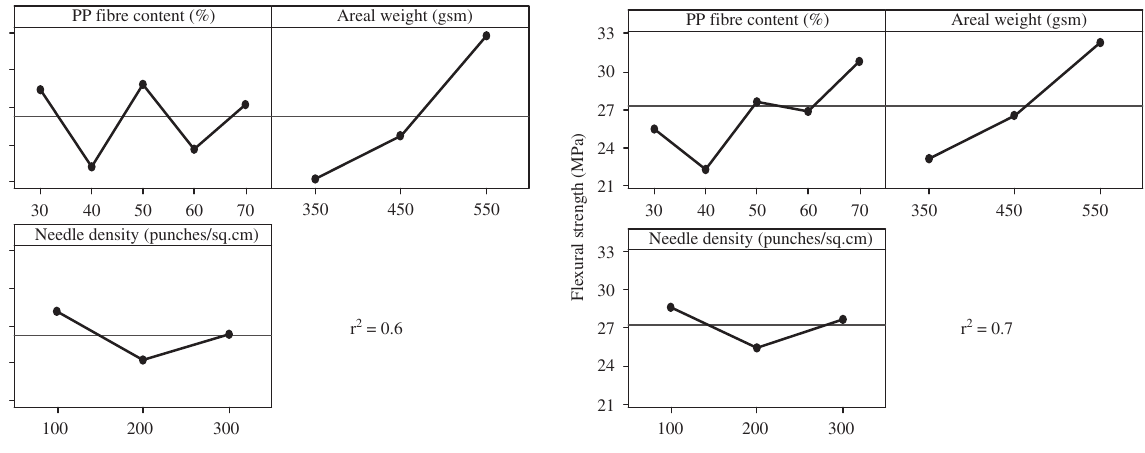
Figure 9: Flexural properties of